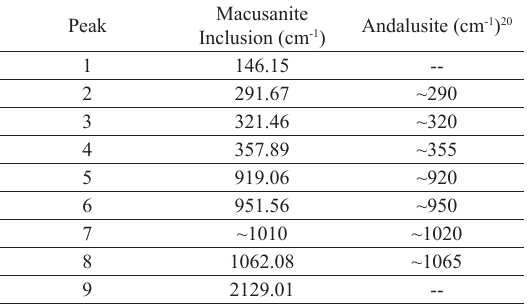
Table 2. Raman Shift of peaks in Macusanite inclusion and Andalusite. Peak